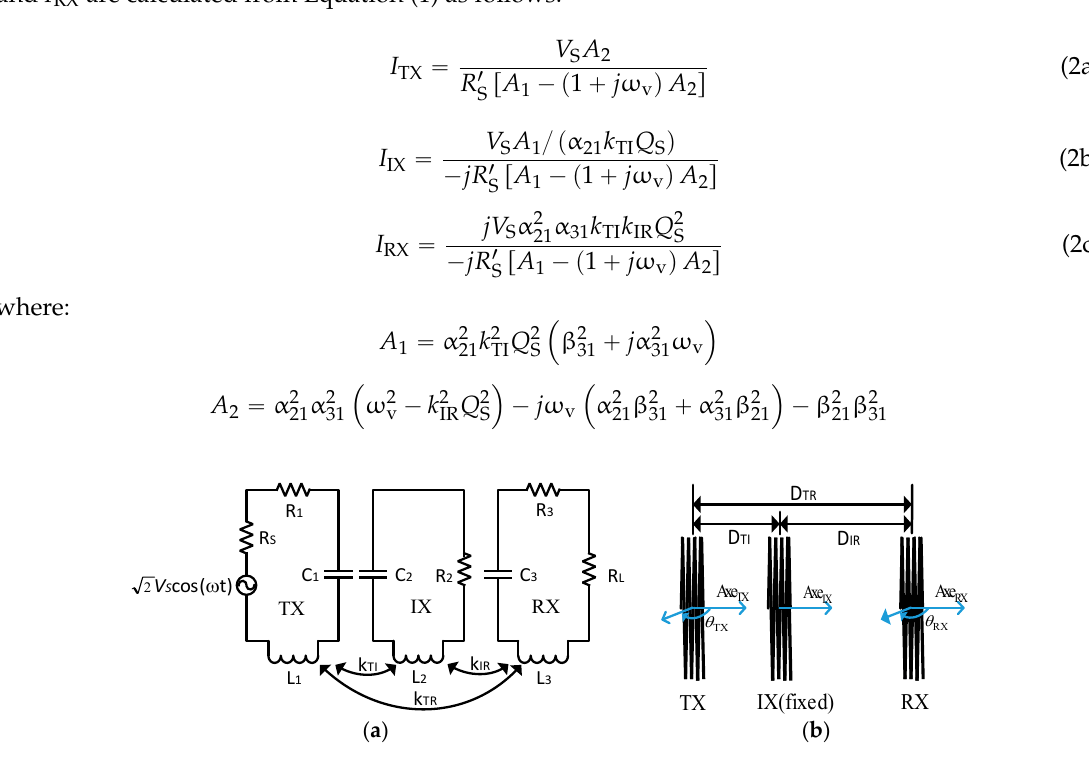
Figure 1. Three ‐ resonator wireless power transfer (WPT) system: ( a ) Equivalent circuit; and Figure 1. Three-resonator wireless power transfer (WPT) system: ( a ) Equivalent circuit; and ( b ) Schematic diagram. ( b ) Schematic